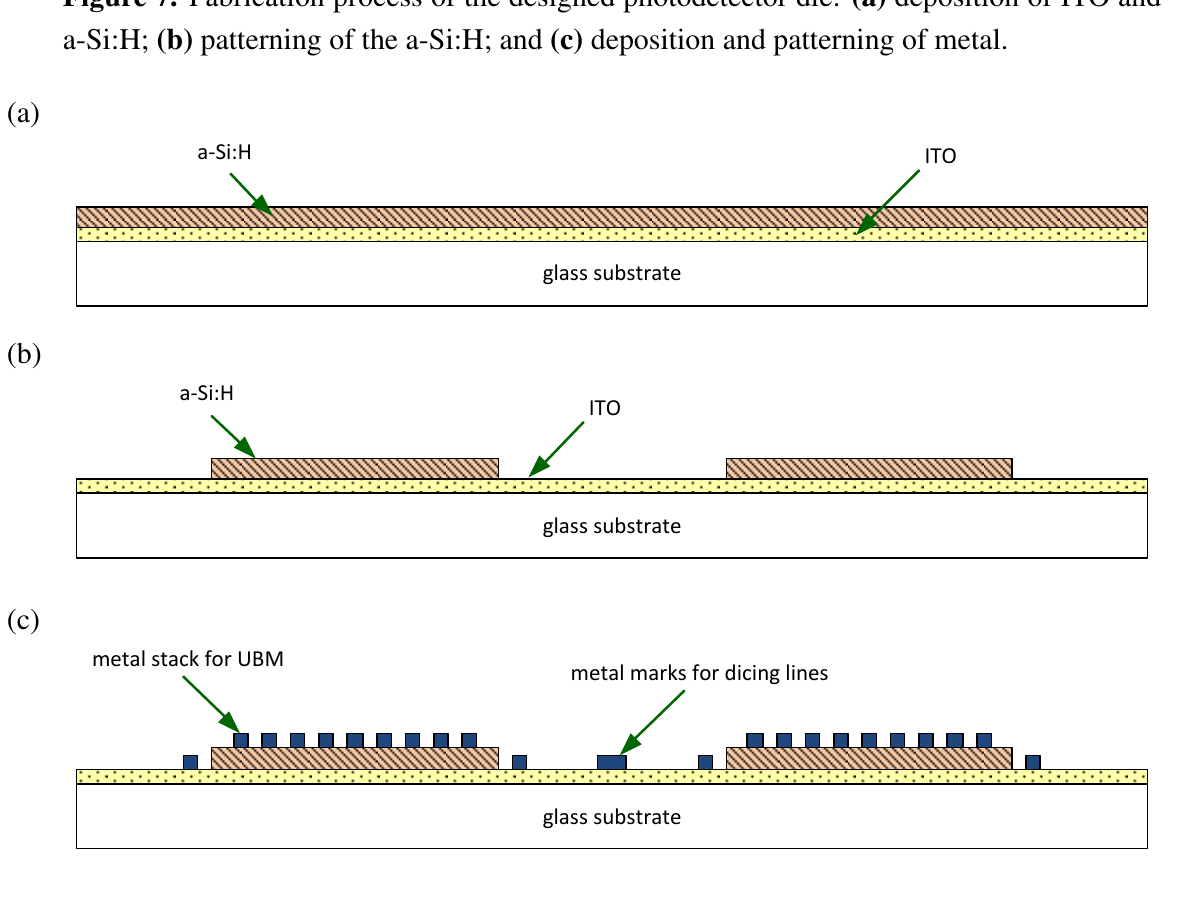
Figure 7. Fabrication process of the designed photodetector die: (a) deposition of ITO